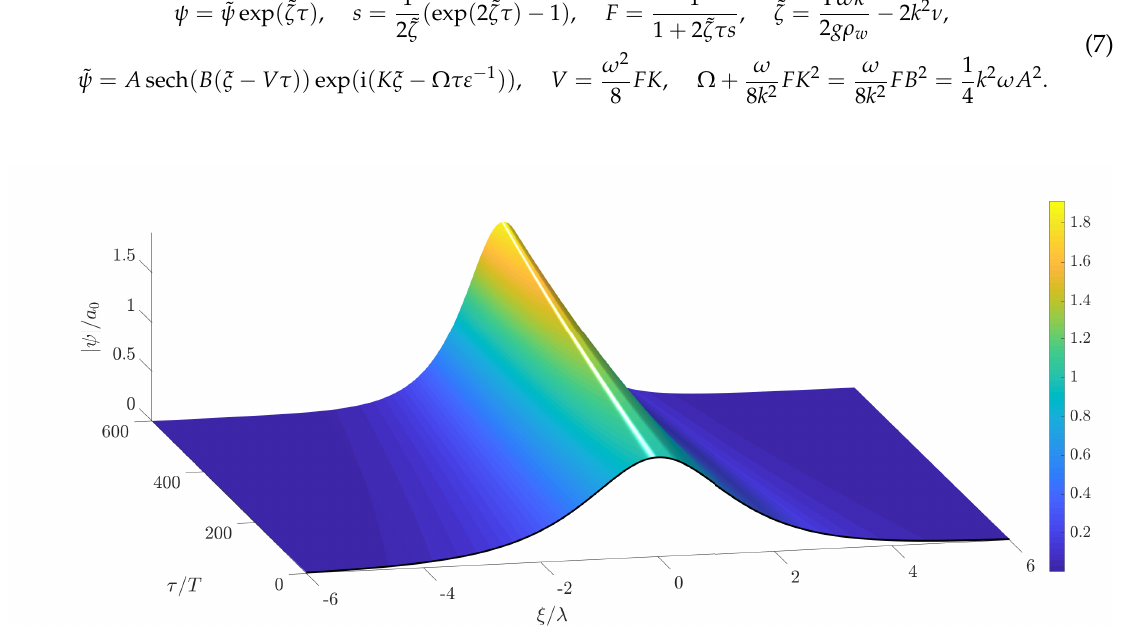
Figure 2. Temporal evolution of a solitary wave solution of the constantly forced NLS